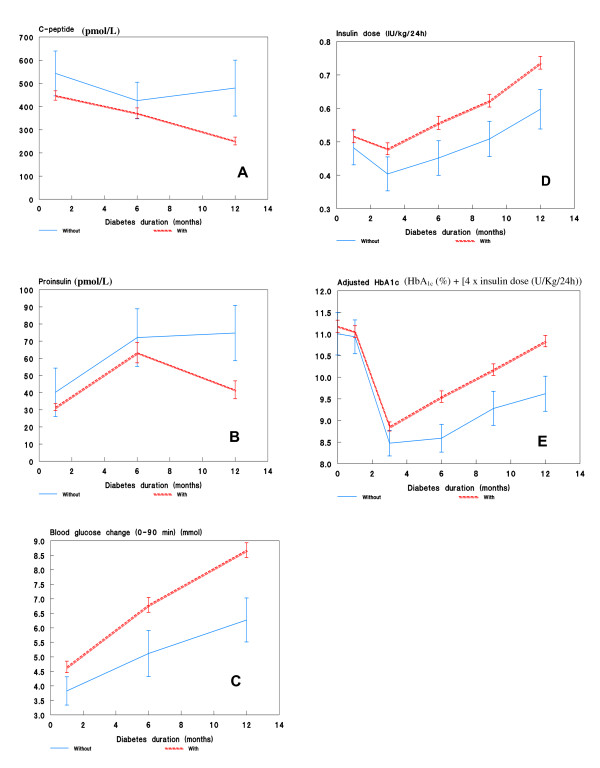
Comparison of disease course in autoantibody-negative and autoantibody-positive children: A: 12 months after disease onset, the residual beta cell function in autoantibody-negative patients was twofold higher than in autoantibody-positive patients (p = 0.002). B: Autoantibody-negative patients had significantly higher proinsulin release 12 months after disease diagnosis than autoantibody-positive subjects (P = 0.01). C: The blood glucose change (90 minutes value minus fasting value) during meal-stimulation differed significantly between autoantibody-negative and autoantibody-positive patients 12 months after disease onset (P = 0.004). D: 12 months after diagnosis autoantibody-negative patients received about 0.15 IU/kg/day less insulin than autoantibody-positive subjects (P = 0.02). E: Autoantibody-negative subjects had 0.8% lower IDAA1c than autoantibody-positive patients (P = 0.02).